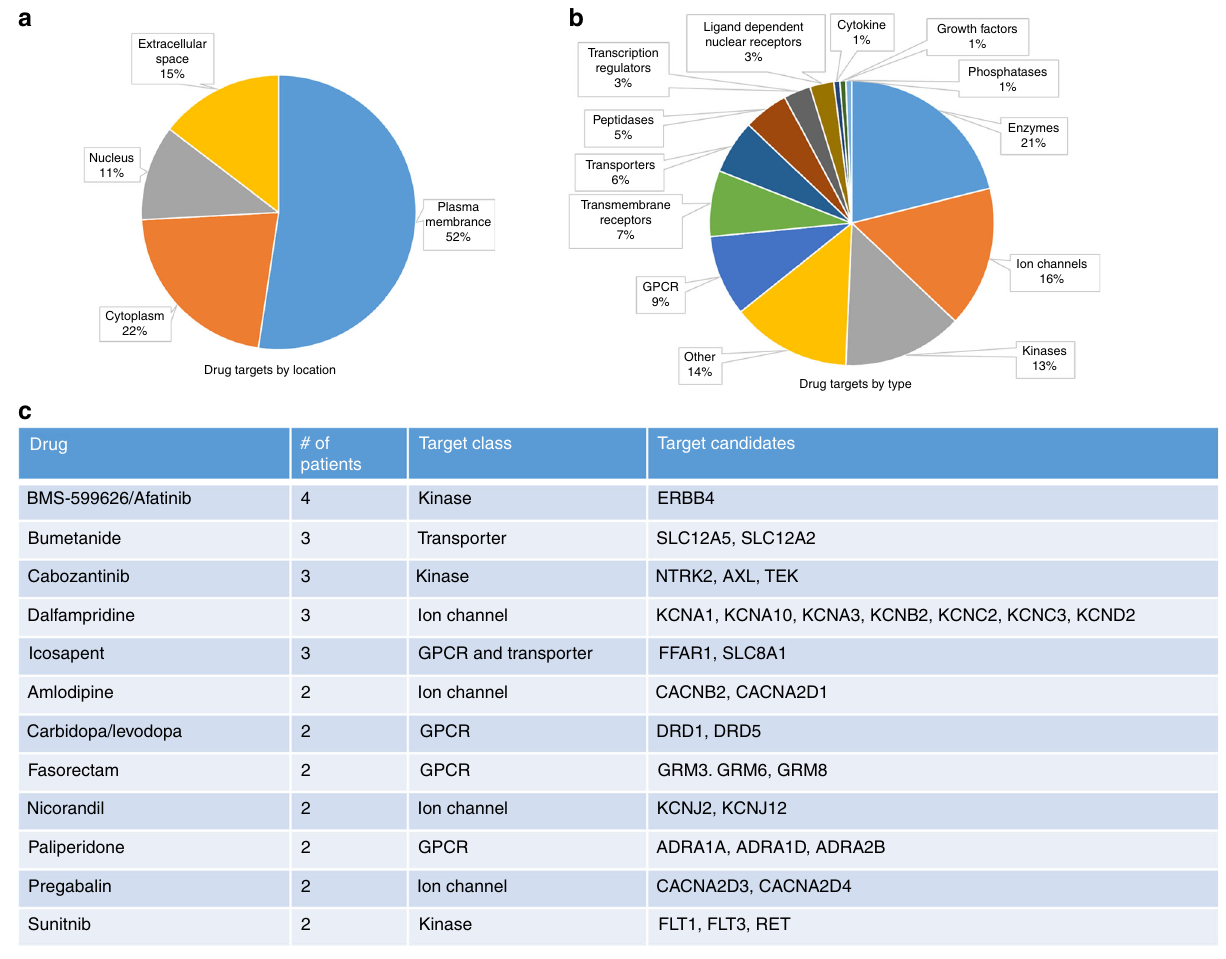
Fig. 6 Potential drug candidates for metastatic ACC. Recurrent gene mutations in metastatic ACC and the druggable targets based on location ( a ) and type ( b ). List of selected drugs and number of patients with mutations that can be targeted with the agent ( c ) NATURE COMMUNICATIONS| (2018) 9:4172 |DOI: